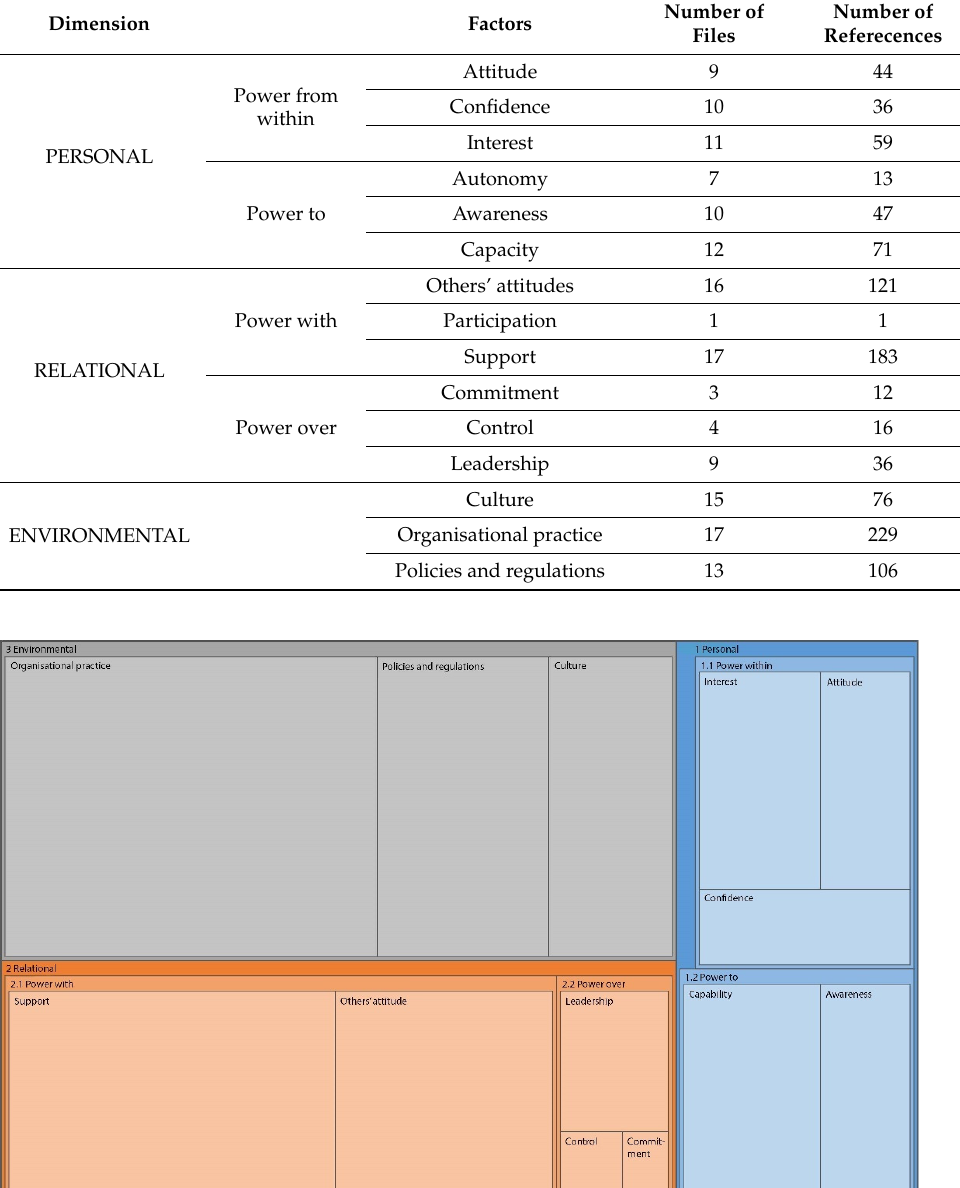
Table 3. Number of files and references coded at each of the nodes, or factors of empowerment.